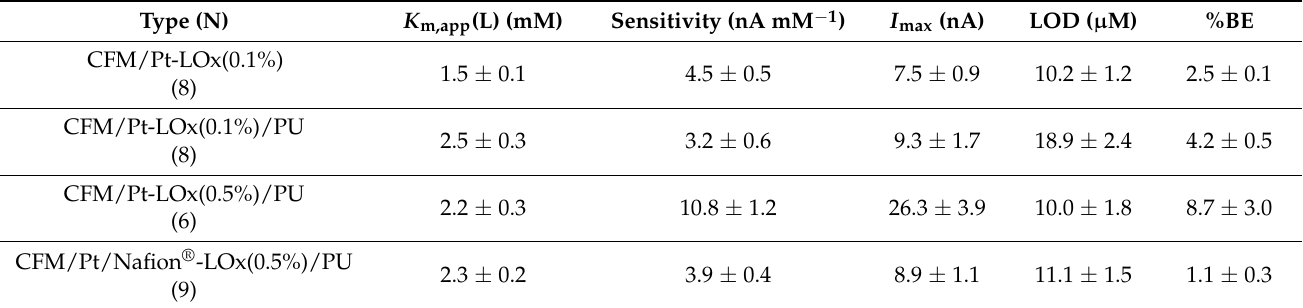
Table 1. Enzyme kinetics and analytical parameters of the CFM/Pt-based